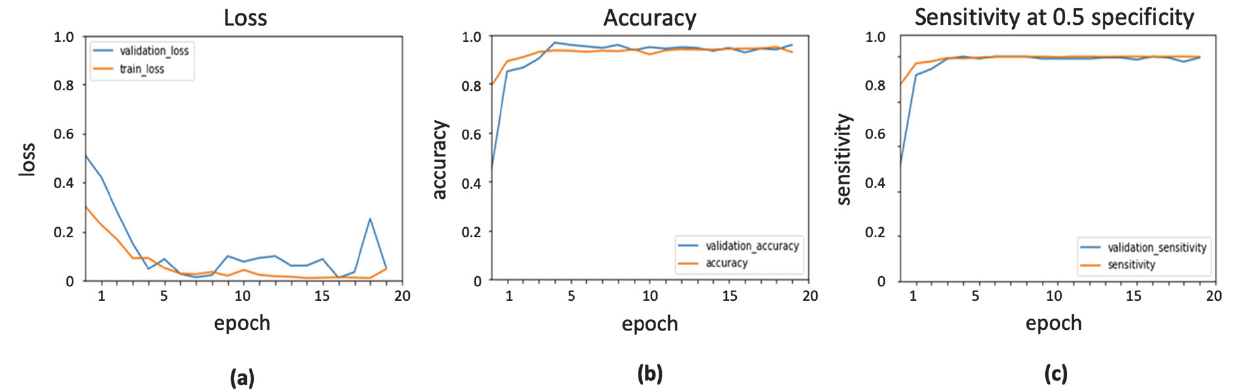
Figure 4. Output obtained using ADAM optimizer: ( a ) loss function; ( b ) accuracy; ( c ) sensitivity.